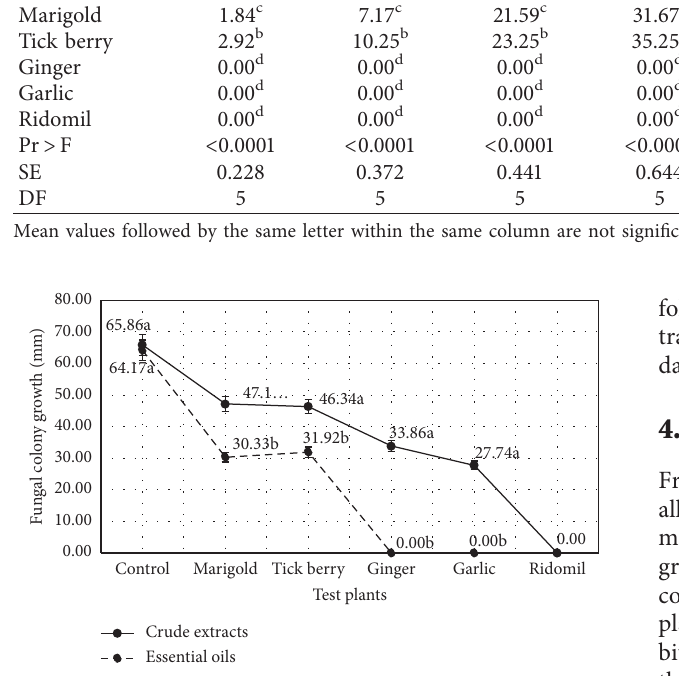
Figure 3: Comparative response of crude extracts and essential oils on the fungal pathogens. Means with the same letter under the same test plant are not significantly different based on SNK test at p � 0 . 05. Means on the same curve whose error bars are over- lapping are not significantly